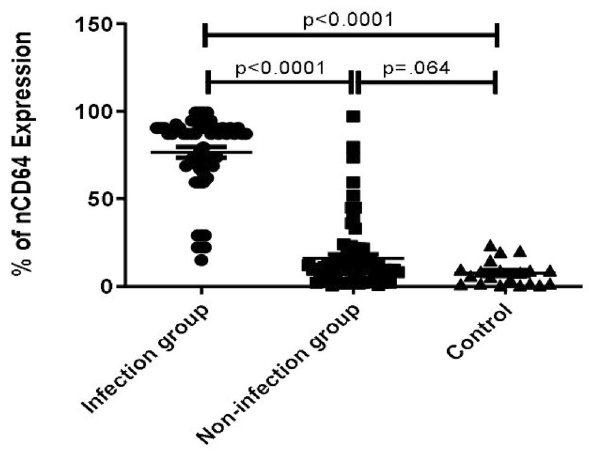
Figure 2. Scatter plot showing distribution of neutrophil CD64 expression between severe alcoholic hepatitis patients with and without infection vs healthy controls.